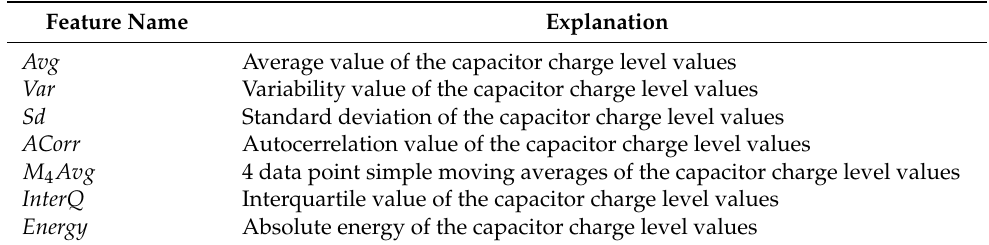
Table 6. Calculated statistical features used as SVR model input